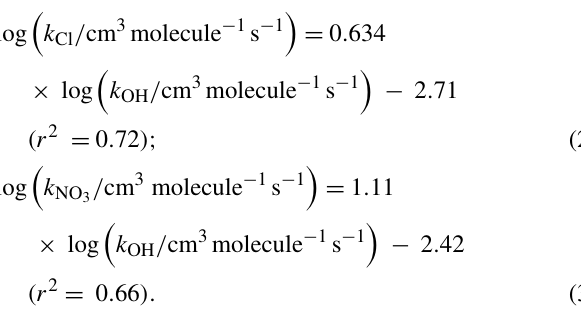
Table 2. Estimated and experimental rate coefficients ( k SAR , k log , and k exp ) for the reaction of SAs with atmospheric oxidants and the ratio of rate coefficients ( k exp /k SAR and k exp /k log ). k Cl / 10 − 11 , k OH / 10 − 12 , and k NO second (cm 3 molecule − 1 s − 1